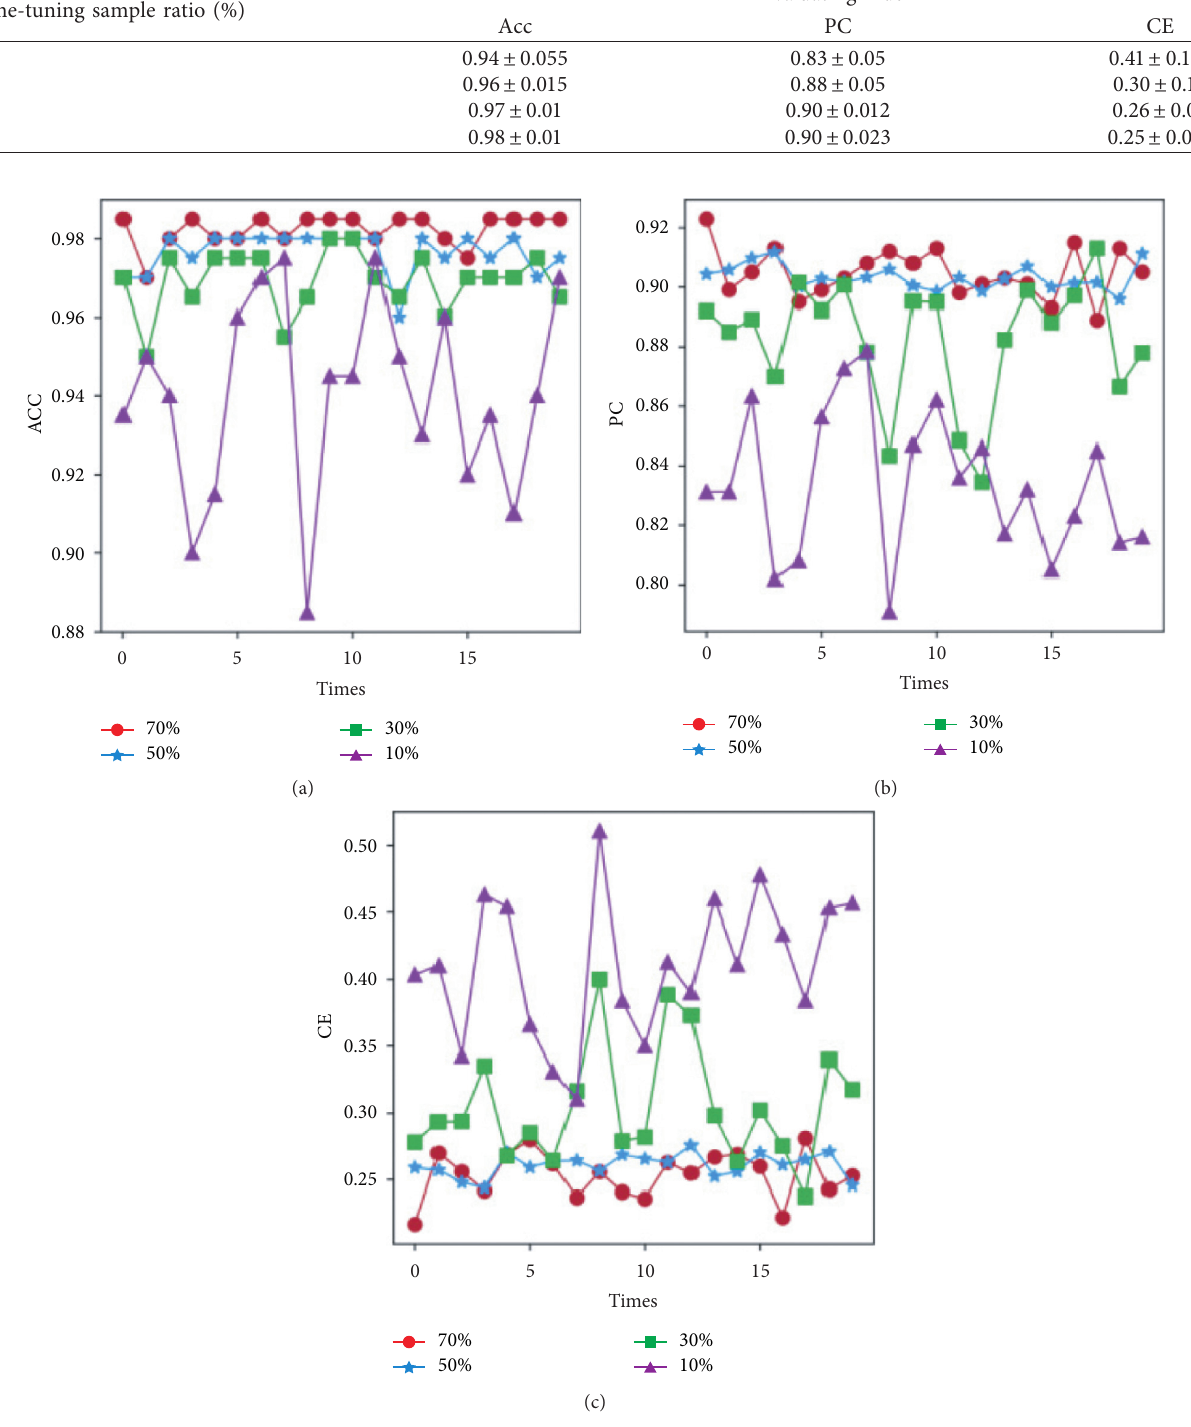
Figure 6: Test results with different proportions of fine-tuned